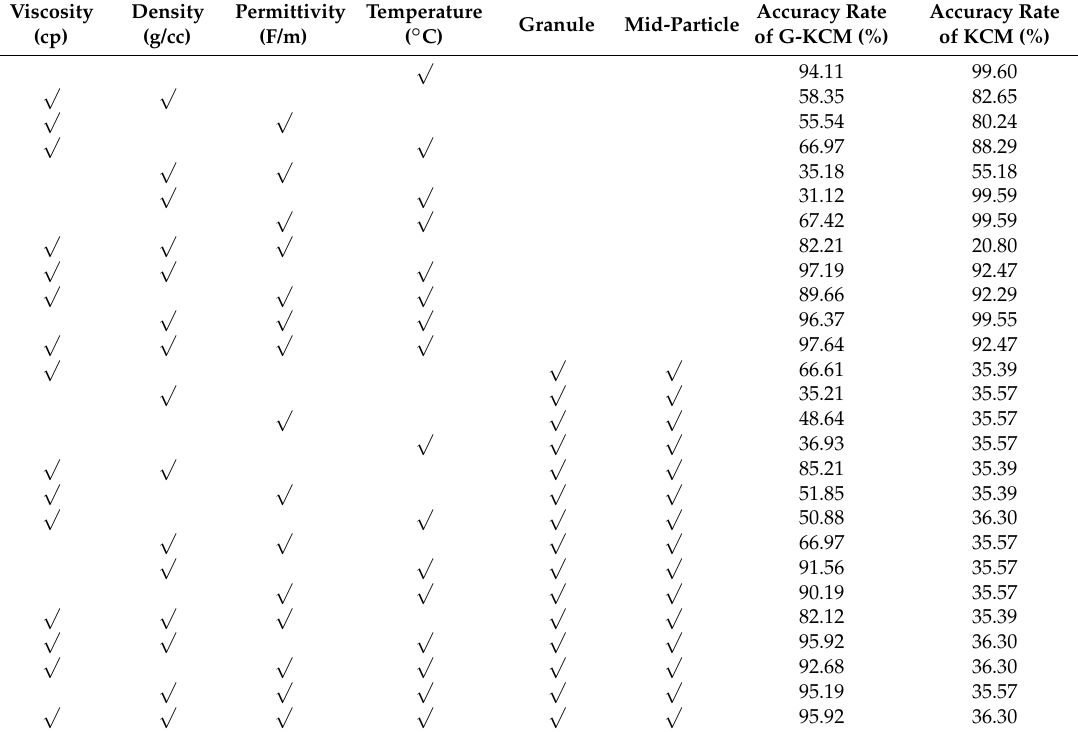
Table 7. The accuracy rate of different multi-parameter